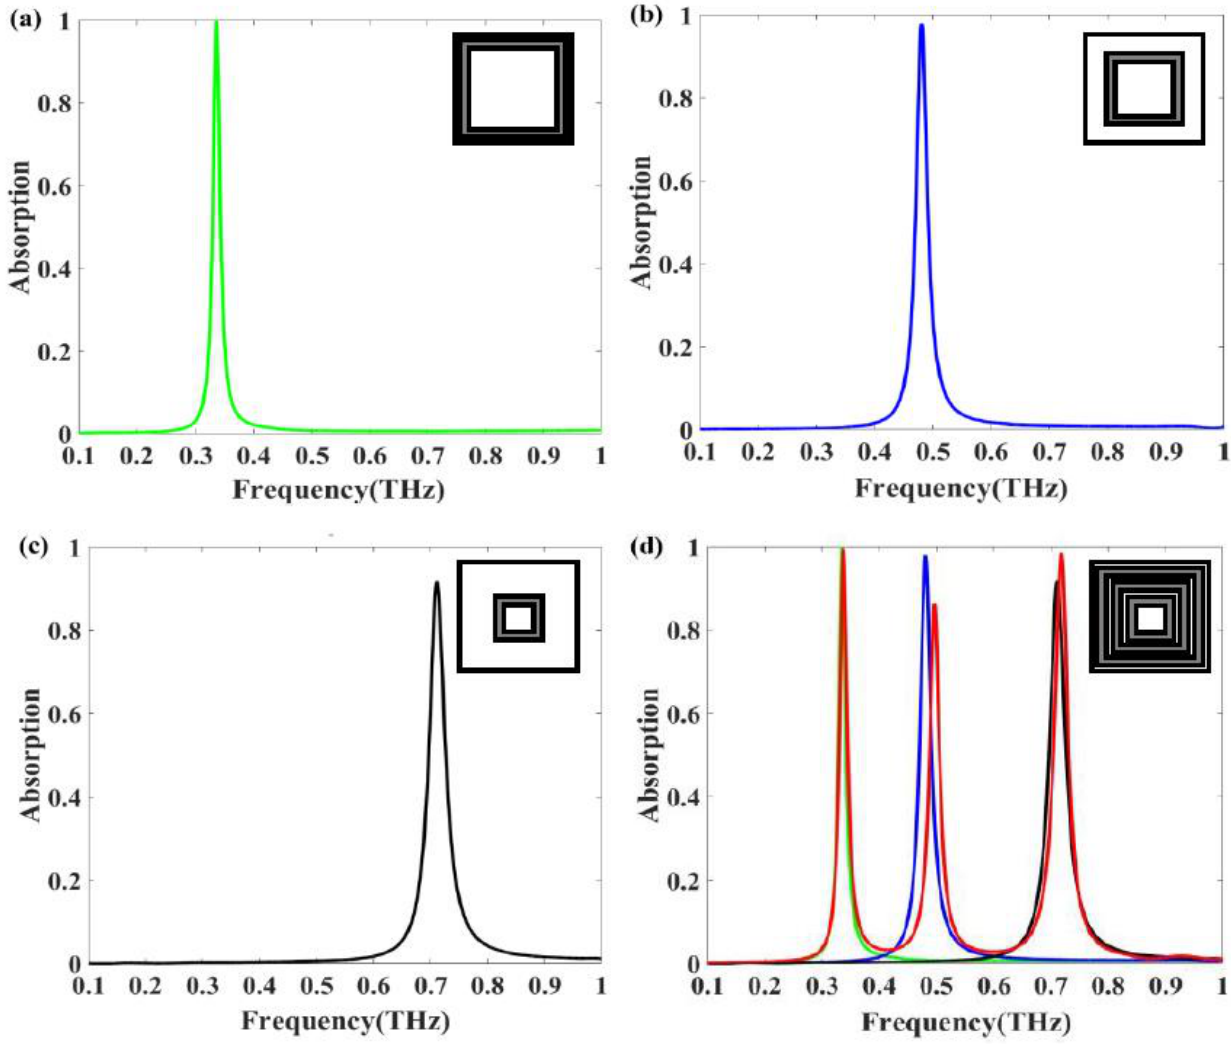
Figure 4. Simulated absorption spectra of absorbers: ( a ) outer square ring resonator; ( b ) middle square ring resonator; ( c ) inner square ring resonator; ( d ) resonator with three concentric square rings.